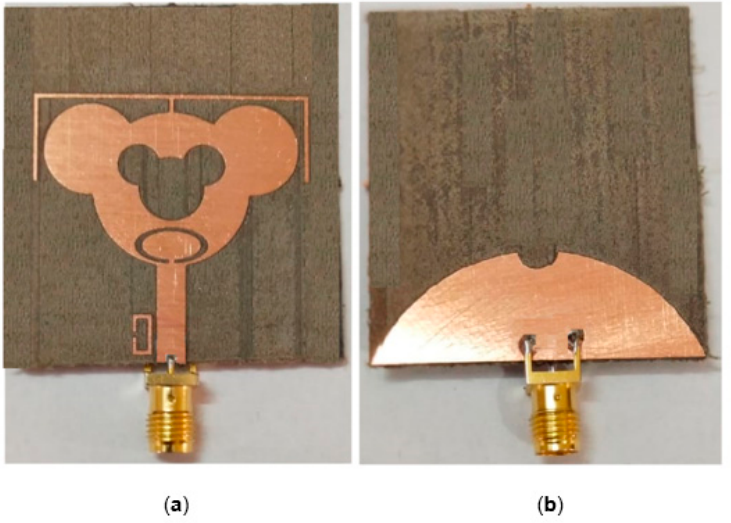
Figure 10. Fabricated antenna showing ( a ) E-shaped stub, split elliptical slot, and C-shaped resonator on Rogers’s board (front view), and ( b ) elliptical ground plane (rear view).